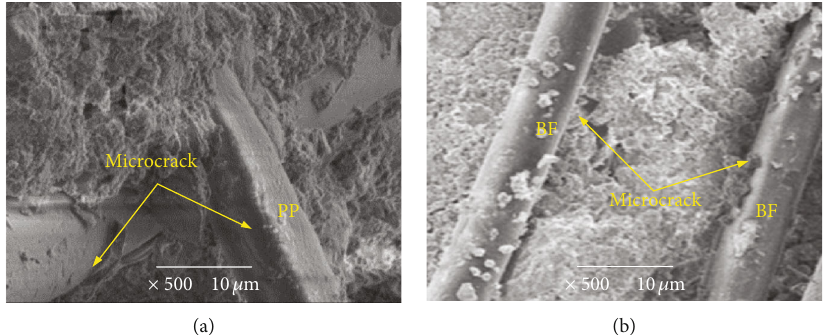
Figure 12: ITZ between the fi ber-mortar (a) PP-mortar and (b) BF-mortar.